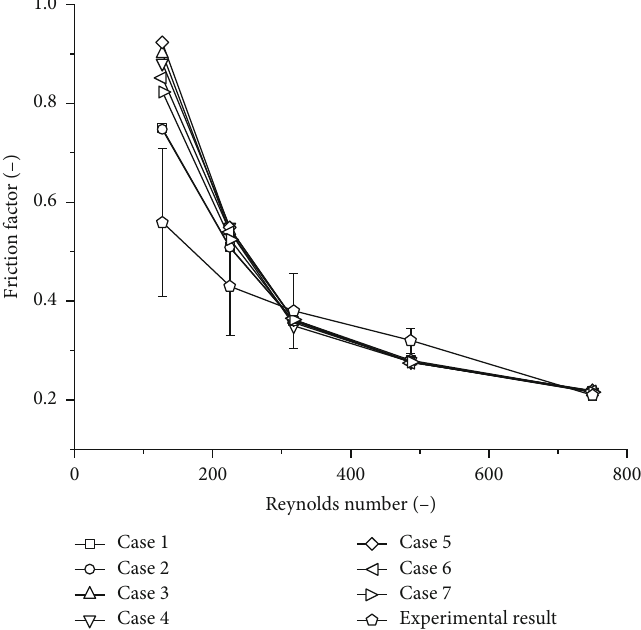
Figure 5: Calculation results of di ff erent